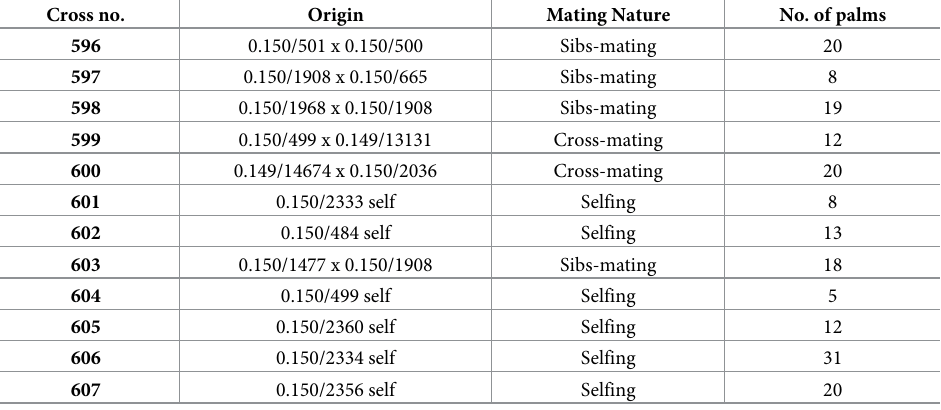
Table 1. Summary of the AAR’s Nigerian-based germplasm collection assayed in this study. Cross